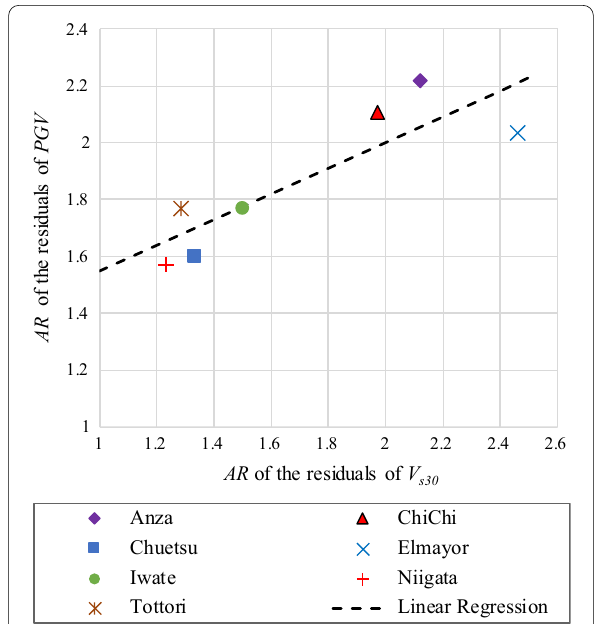
Fig. 6 AR of the residuals of the PGV versus AR of the normalized values of the V s30 for different earthquakes